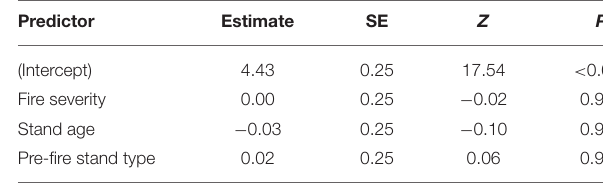
Plot was the random effect (SD: 1.44). The dispersion parameter was 0.51. SE, standard error of the mean.